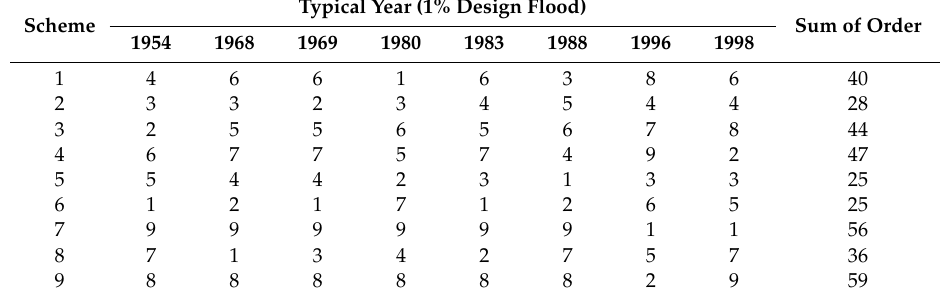
Table 8. Ranking order of different schemes in different typical years.